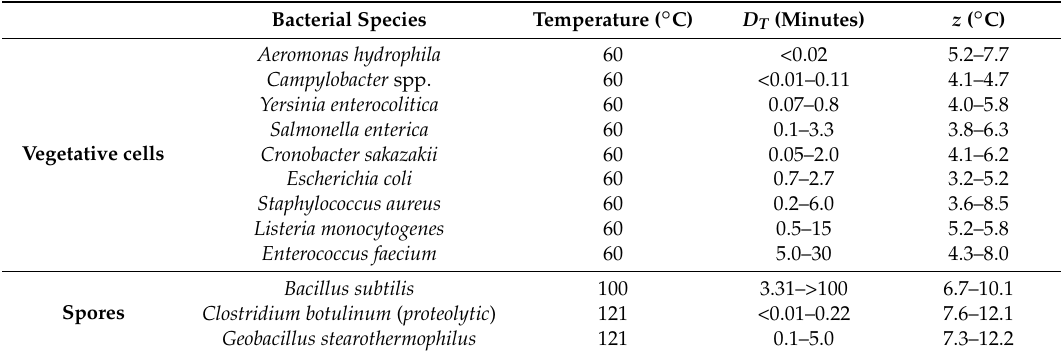
Table 1. Range of D T values of different bacterial species in buffers and foods (pH range 5.5–7.0; a w > 0.98). Sources